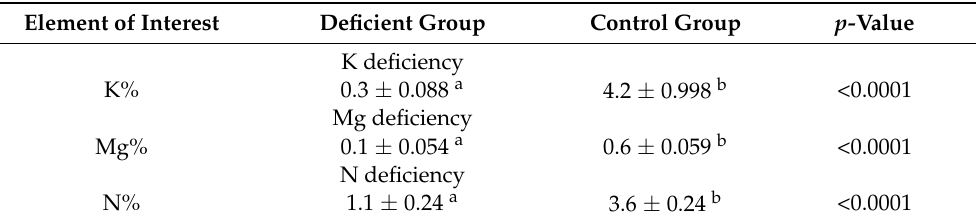
Table 1. Comparison of elemental concentration in nutrient deficient and control plants. Elemental concentration is expressed as the percentage of dry matter in the leaf. K and Mg were analysed in the petioles while N was analysed in the leaf blades. Element of Interest Deficient